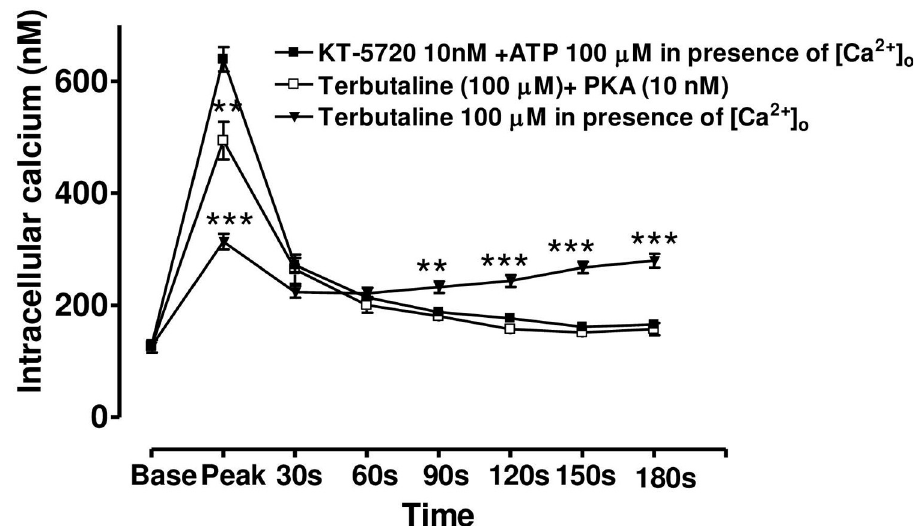
Fig 9. The effect of the PKA inhibitor, KT-5720 (10nM), on the terbutaline-induced inhibition of [Ca 2+ ] i increase by ATP. Cells were incubated with either KT-5720 (10nM), or terbutaline (100 μ M) alone or with KT-5720 (10nM) and terbutaline (100 μ M) together for 6 min before stimulating by ATP (100 μ M). KT-5720 largely reversed terbutaline- induced inhibition of the rapid phase of Ca2+ release by ATP. On the other hand, it completely abolished terbutaline- induced augmentation of the plateau phase of the ATP response. Each point is a mean ± s.e.mean of 7–10 experiments. Significance of differences from 100 μ M terbutaline treated response; �� p < 0.01 and ��� p < 0.001, Bonferroni’s multiple comparison test. Base value indicates the [Ca 2+ ] i prior to addition of